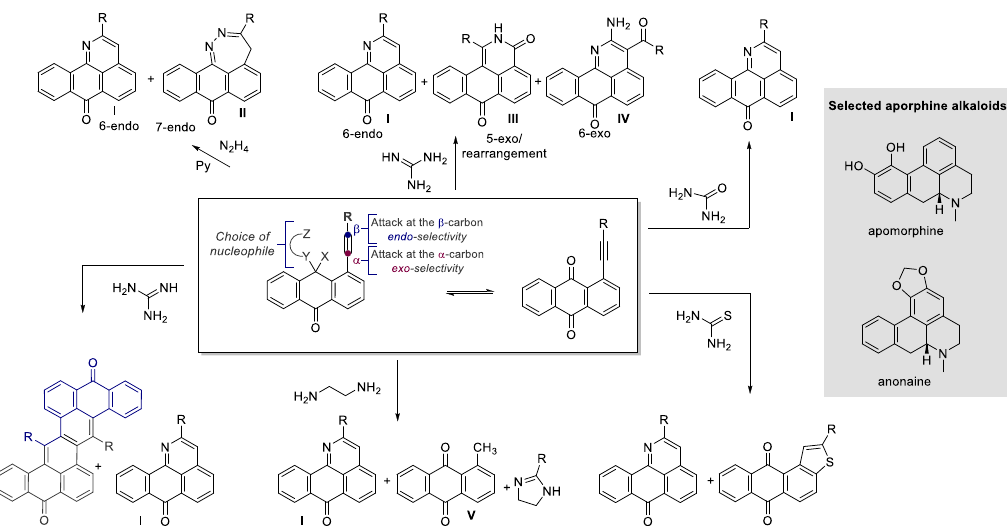
Scheme 1. The variety of cyclization pathways in reactions of multifunctional nucleophiles with 1-(R-ethynyl)-9,10-anthraquinones. Selected aporphine alkaloids are shown in the grey box.